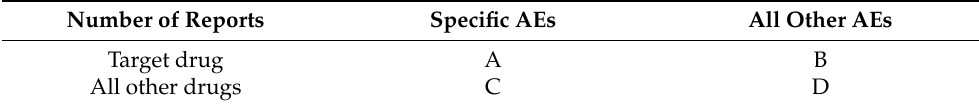
Table 1. Two-by-two contingency table for disproportionality analysis.